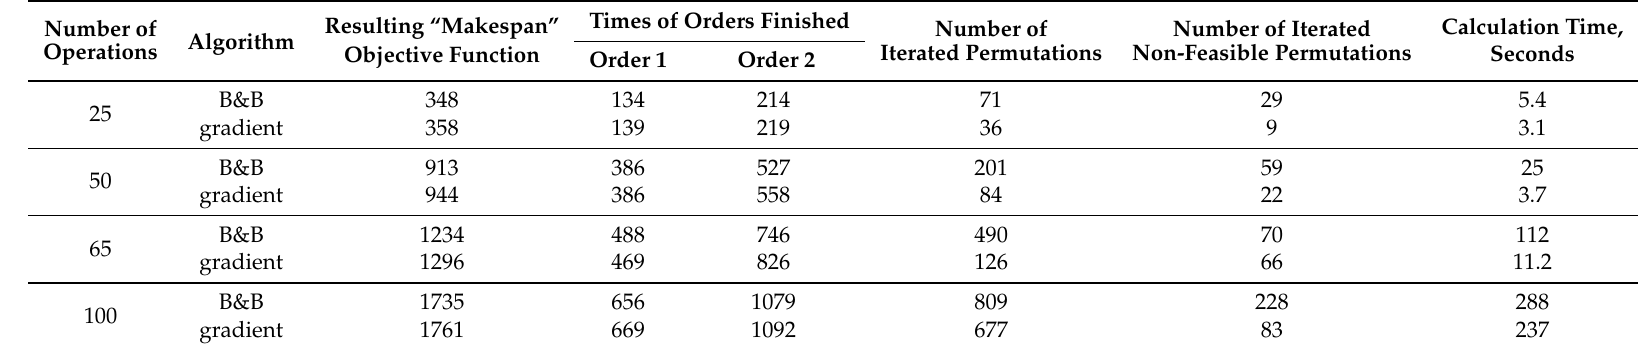
Table 2. Results for 2 orders with number of operations increasing.